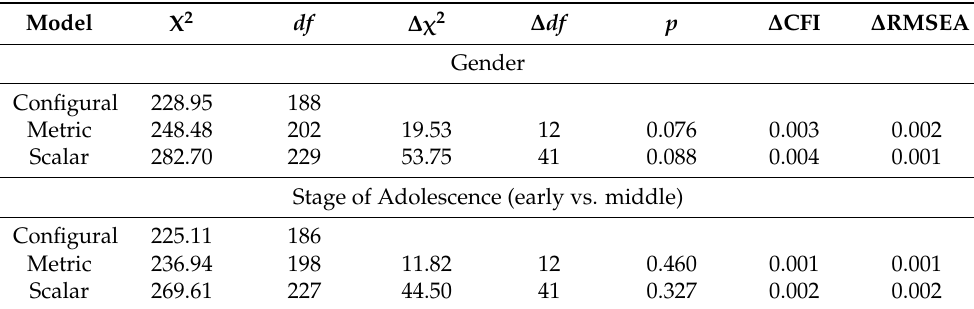
Table 4. Summary of measurement invariance results of one second-order dimensional model of temperance scale ( n =